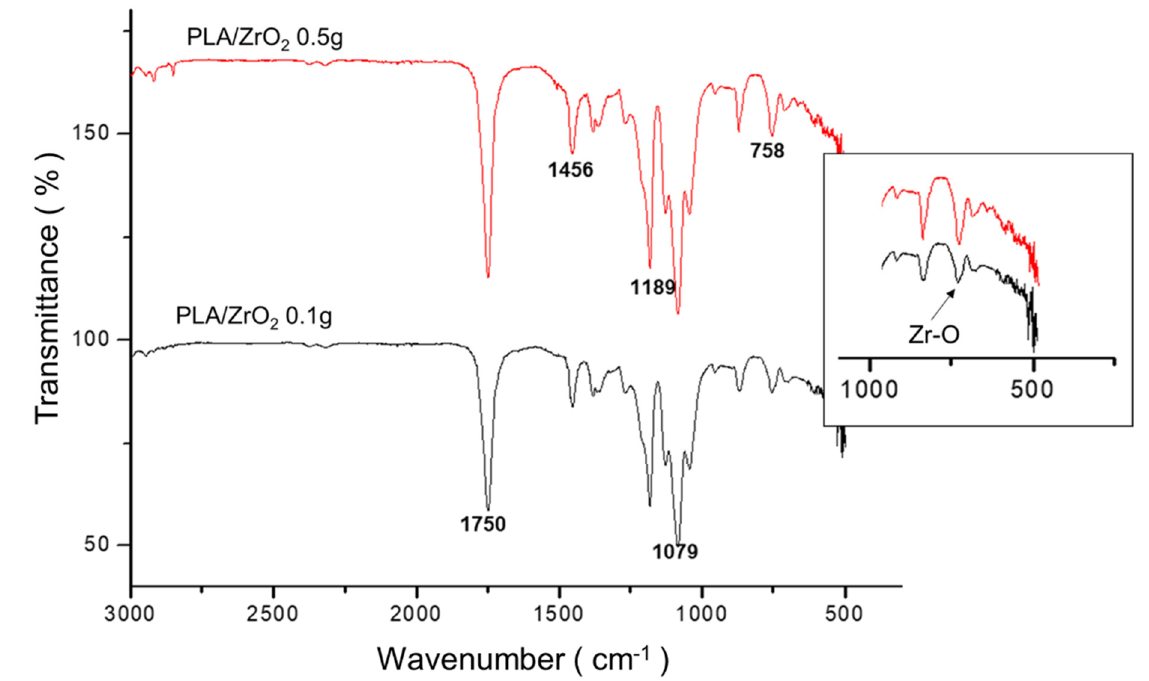
Figure 3. FTIR-IR spectrum of PLA/ZrO 2 fiber membrane scaffolds. The absorption bands typical characteristic of PLA: around 1750 cm − 1 , the (C=O) ester carbonyl group; at 1445 and 1380 cm − 1 , the absorbance bands of C-H bending vibration of CH 3 ; at 1350 cm − 1 , the bending vibration of carbonyl CH; at 960 to 830 cm − 1 , corresponding to the backbone stretching and CH 3 rocking; at the region of 3200 to 2800 cm − 1 , to the symmetric and asymmetric stretch of CH; and at 1260 cm − 1 and 1100 cm − 1 , corresponding to the lactide C-O stretch, with 1090 – 1189 cm − 1 (C-O=C) and 758 cm − 1 attributed to (Zr–O). The insert image of the absorption band of Zr-O at 758 cm − 1 was magnified for show the differences between the PLA/ZrO 2 with 0.1 g and 0.5 g composite scaffold.